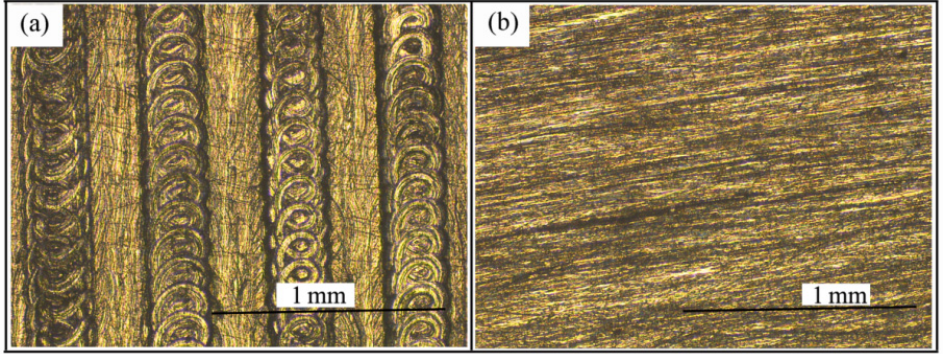
Figure 5. Surface texture before ( a ); and after ( b ) brush grinding experiment.